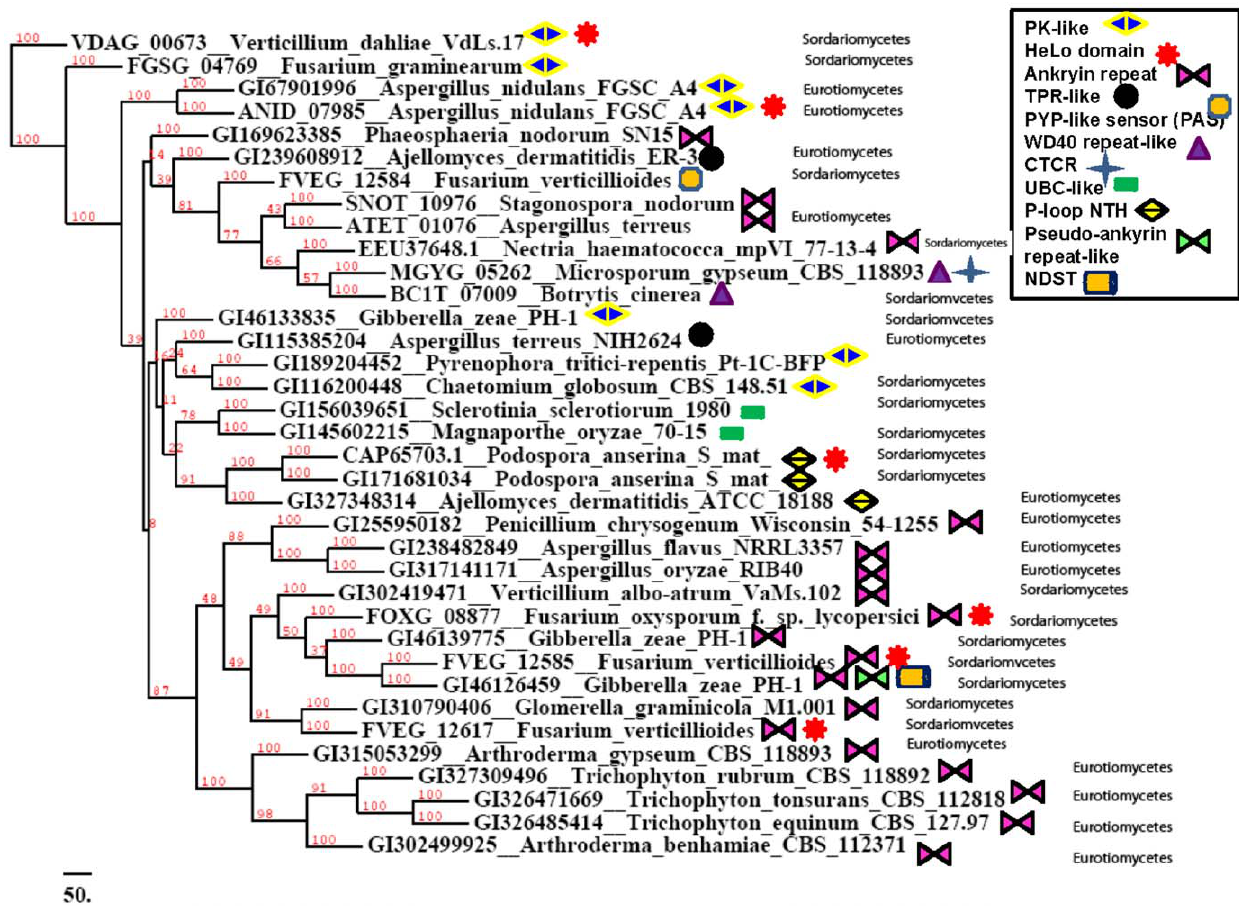
Figure 8. SUPERFAMILY associations with the N-terminal homologs (n=36). A majority-rule consensus tree is generated for N-terminal homologs which are significantly associated with families identified using SUPERFAMILY. The clades of the different proteins are also annotated, especially for proteins which belong to ‘Sordariomycetes’ or ‘Eurotiomycetes’. Superfamilies associated with each protein are indicated, and are abbreviated as follows: CTCR: C-term (heme d1) of cytochrome reductase. P-loop NTH: P-loop containing nucleoside triphosphate hydrolase. NDST: Nucleoside-diphospho-sugar transferase.